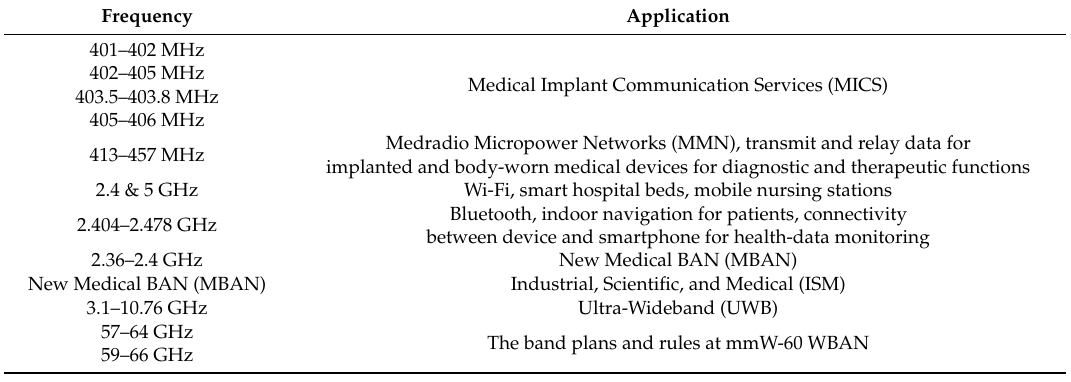
Table 1. Frequency bands for BAN application.